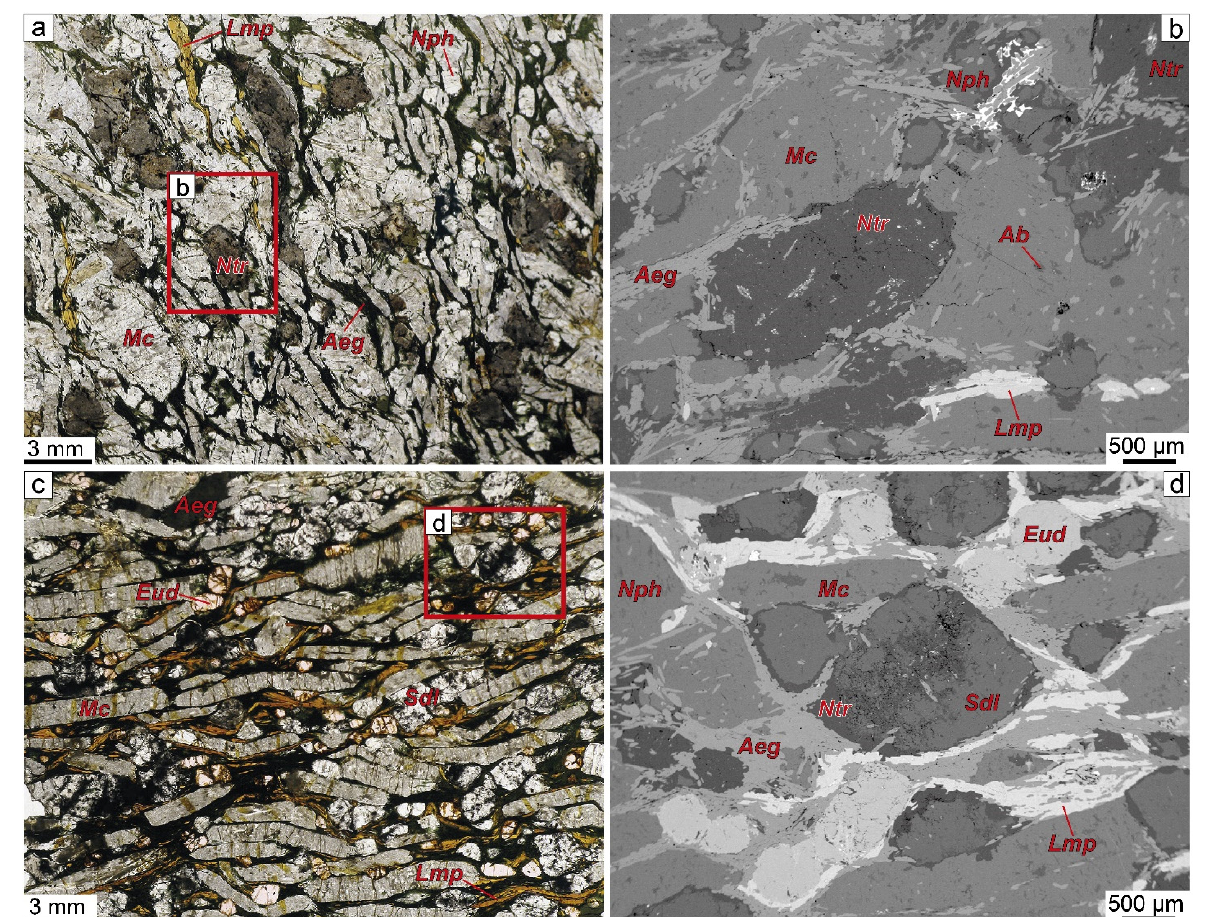
Figure 7. Photographs in transmitted light ( a , c ) and BSE images ( b , d ) showing the textural relations and mineral paragenesis in lujavrite near the contact with poikilitic rocks. ( a ) Leucocratic lujavrite (20 cm from contact with poikilitic foid syenite, sample LV-377-3). Both large rectangular microcline crystals (supposedly, the result of recrystallization) and microcline laths are present. ( b ) Detail of Figure 7a (red rectangle). Intensive natrolitization of the rock is observed. ( c ) Eudialyte lujavrite enriched in sodalite (40 cm from contact with poikilitic foid syenite, sample LV-377-2). The sodalite content is 35 modal%. ( d ) Detail of Figure 7c (red rectangle). Sodalite is intensively replaced by natrolite.